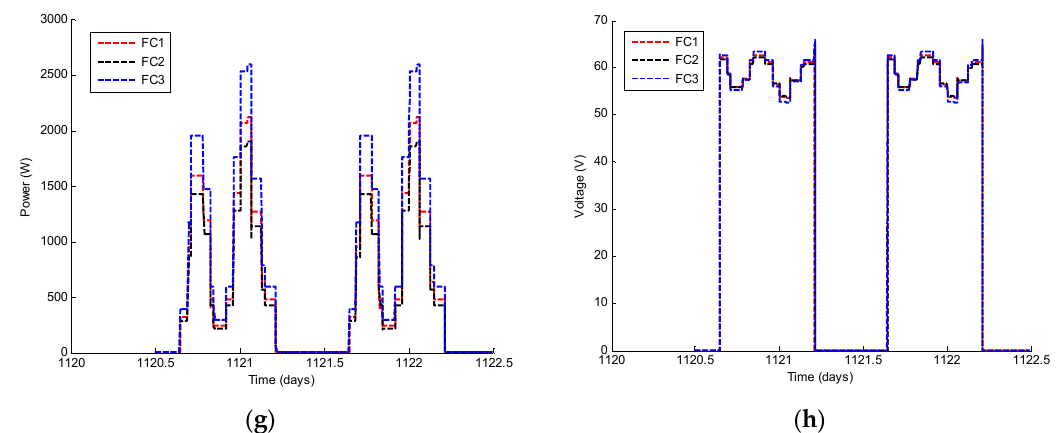
Figure 8. Delivered power and voltage of the stacks 1, 2, and 3 of the multi-stack FC system operating with MPC controller at different times. ( a , b ) Days 3 and 4. ( c , d ) Days 361 and 362. ( e , f ) Days 721 and 722. ( g , h ) Days 1121 and 1122.